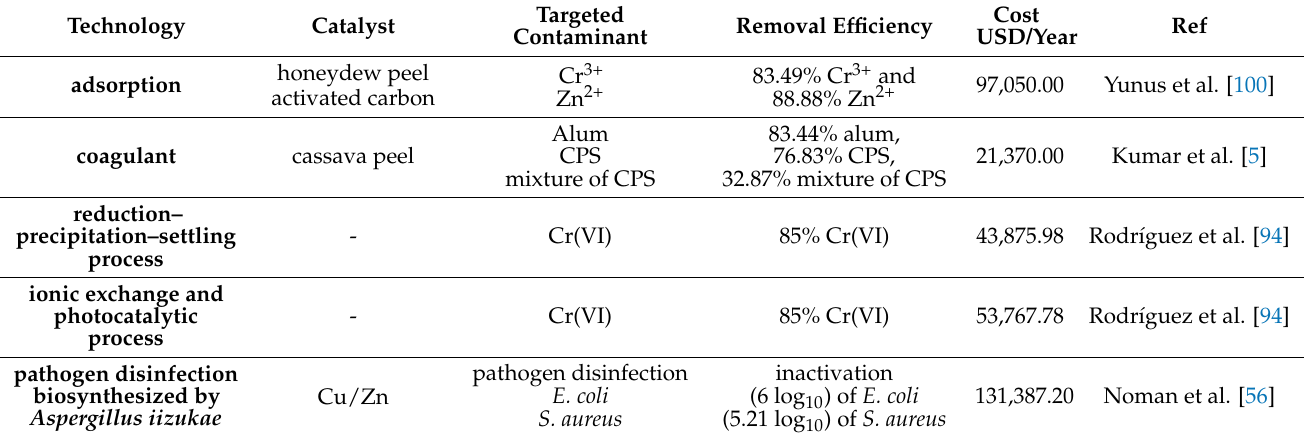
Table 4. Cost of operating different technologies for heavy metal and pathogen removal in